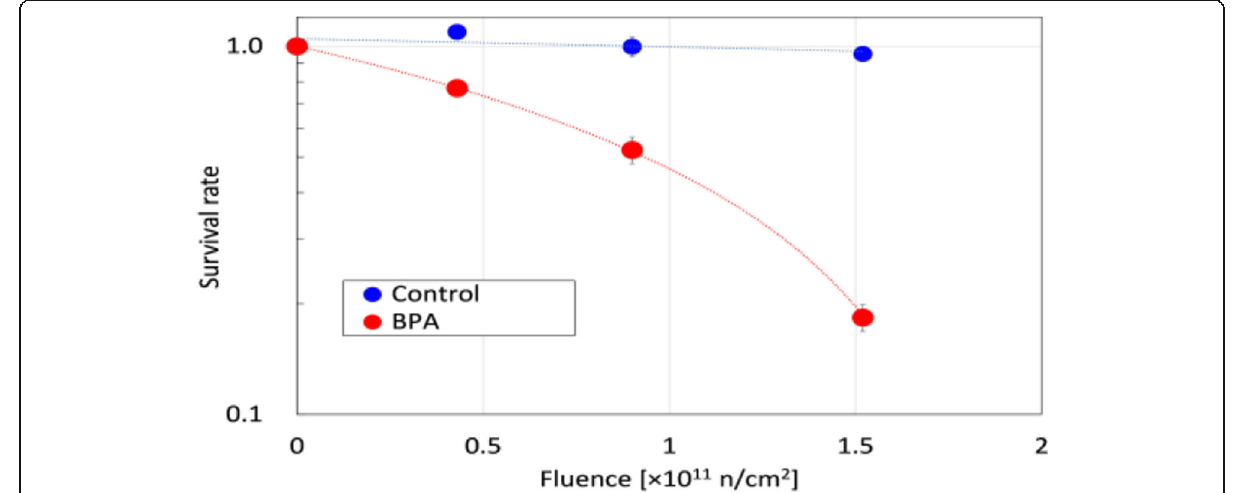
Fig. 3 Comparison between the control group and the BPA